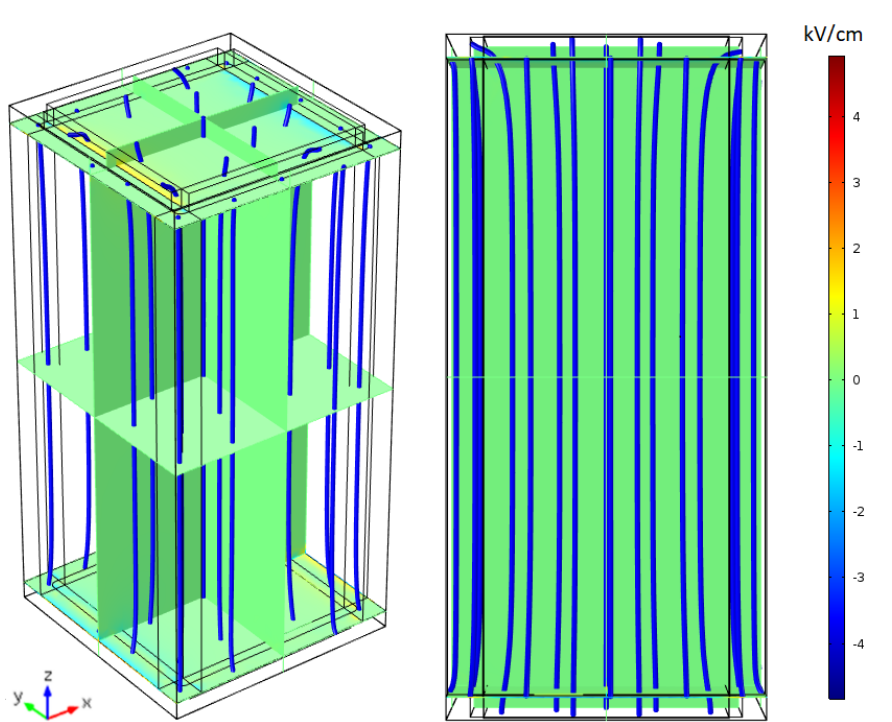
Figure 11. Electric-field lines (blue tubes) and the electric-field distortions in x direction only (slices), simulated with COMSOL Multiphysics. The distortions in x direction are largest, O ( 1 ) kV/cm, very close to the iron frames (yellow and light blue colors) but vanish for most of the active volume (indicated by the green